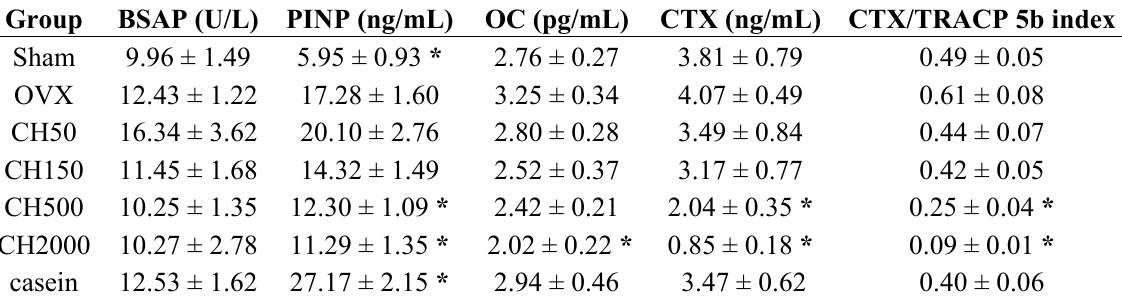
Table 1. Serum parameters of bone turnover. Values are means ± SEM ( n = 12). * p < 0.05 compared with the OVX group. BSAP, bone-specific alkaline phosphatase; PINP, procollagen type I N-terminal propeptide; OC, osteocalcin; CTX, carboxyterminal telopeptide of collagen type 1; CTX/TRACP, ratio of CTX and tartrate-resistant acid phosphatase 5b concentration; sham, sham-operated group; OVX, ovariectomized group; CH50-CH2000, OVX groups treated with collagen hydrolysates (0.1%–0.4%, 50–2000 mg/kg); casein, OVX groups treated with casein (1%, 500